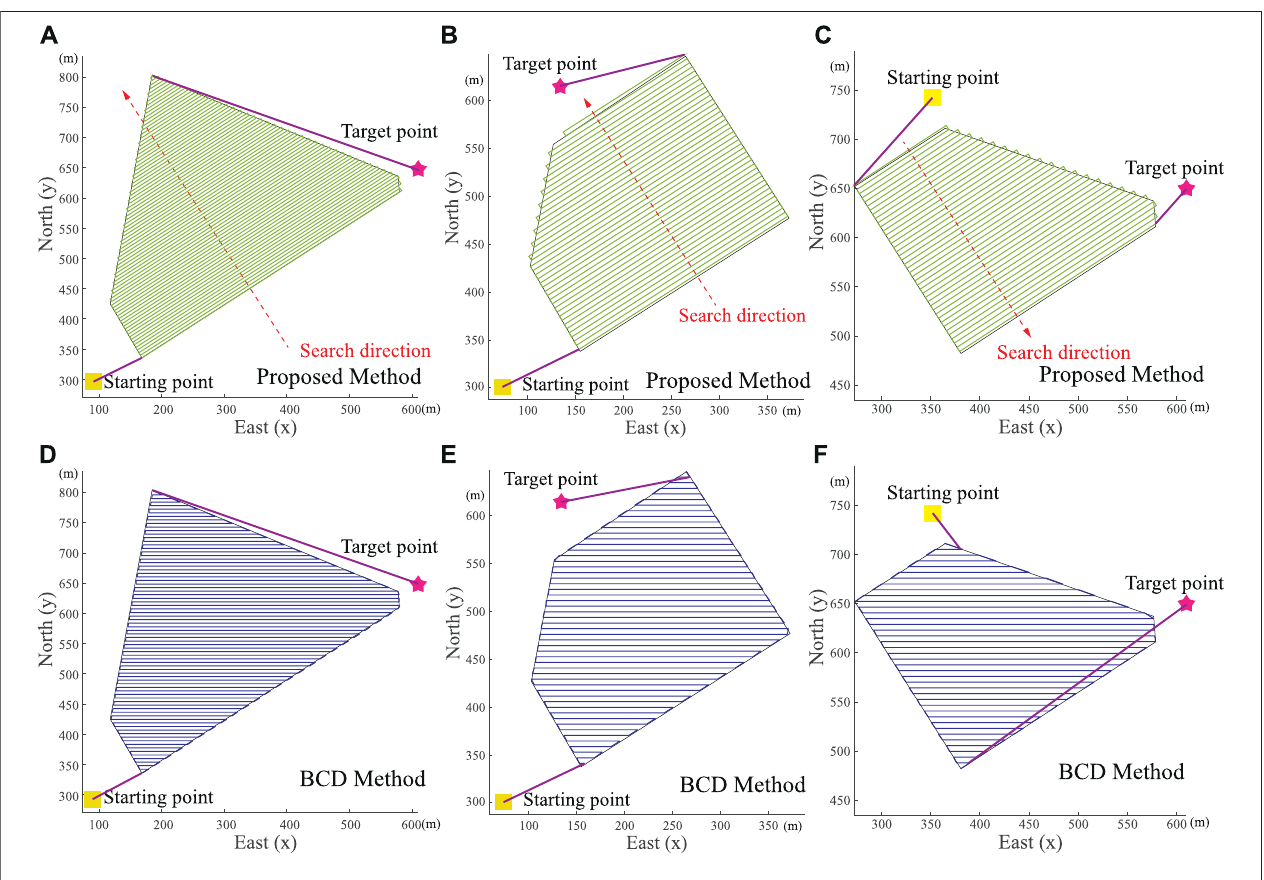
FIGURE 9 | Real-world scenarios of autonomous vehicle CCPP trajectories in Figure 8 . (A – C) Trajectories generated by proposed CCPP method. (D – F) Trajectories generated by Boustrophedon Cellular Decomposition (BCD) method.